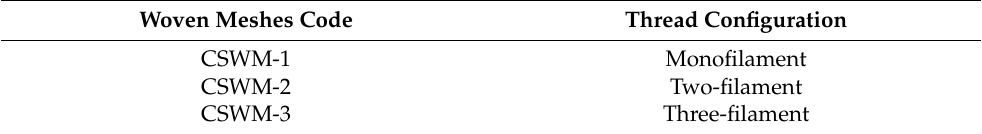
Table 3. The nomenclature used for CS woven meshes. Woven Meshes Code